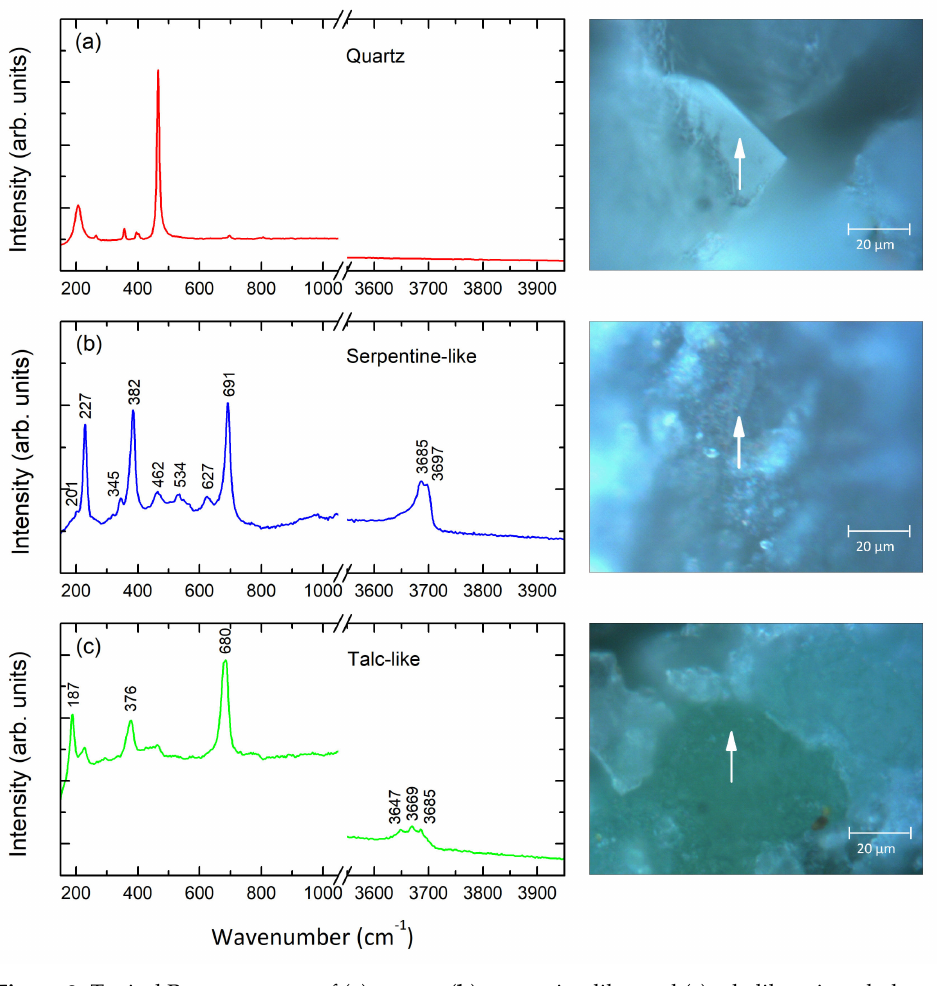
Figure 2. Typical Raman spectra of ( a ) quartz, ( b ) serpentine-like, and ( c ) talc-like mineral phases ac- quired on the garnierite sample. The microscopic images on the right show the sampled area marked by the white arrow. Both Raman spectra and optical images were acquired with an 80 × LWD